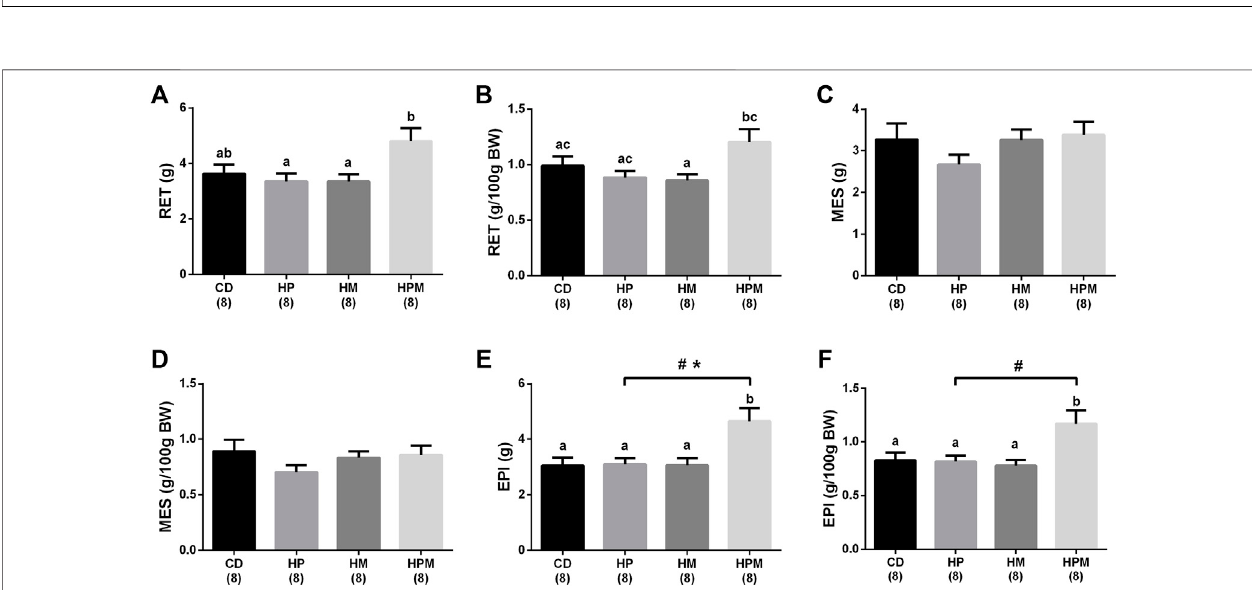
FIGURE2| Adipose tissue data ofmale rat offspring from progenitorsfed onhigh-fat high-sugar diet. Mean ±SEM; symbols indicate signi fi cantdifference caused by the effect of parental diet ( p < 0.05): # statistically signi fi cant by paternal diet; *statistically signi fi cant by the effect of maternal diet. a,b,c Different letters represent signi fi cant difference between groups ( p < 0.05). H: high-fat and high-sugar diet; CD (control paternal and maternal diet), HP (H paternal diet and control maternal diet), HM (H maternal diet and control paternal diet) and HPM (H paternal and maternal diet); BW: body weight; (A) : retroperitoneal adipose tissue (RET) (g); (B) : RET (g/ 100 g BW); (C) : mesenteric adipose tissue (MES) (g); (D) : MES (g/100 g BW); (E) : epididymal adipose tissue (EPI) (g); (F) : EPI (g/100 g BW); ( n = 8).